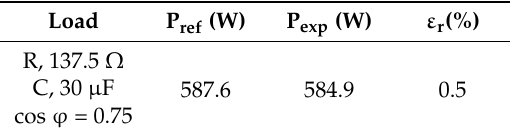
Figure 10. ( a ) Comparison between the experimental (TMR wattmeter) and reference wattmeter (2551 Xitron) active powers; ( b ) Actual active power vs. TMR wattmeter number of counts; ( c ) Obtained experimental relative uncertainty. Table 1. Active power comparison with capacitive load.